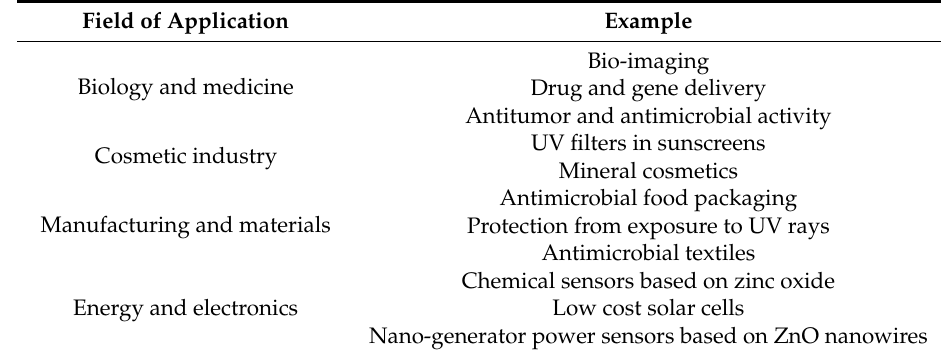
Table 1. Application of Zn/ZnO nanoparticles